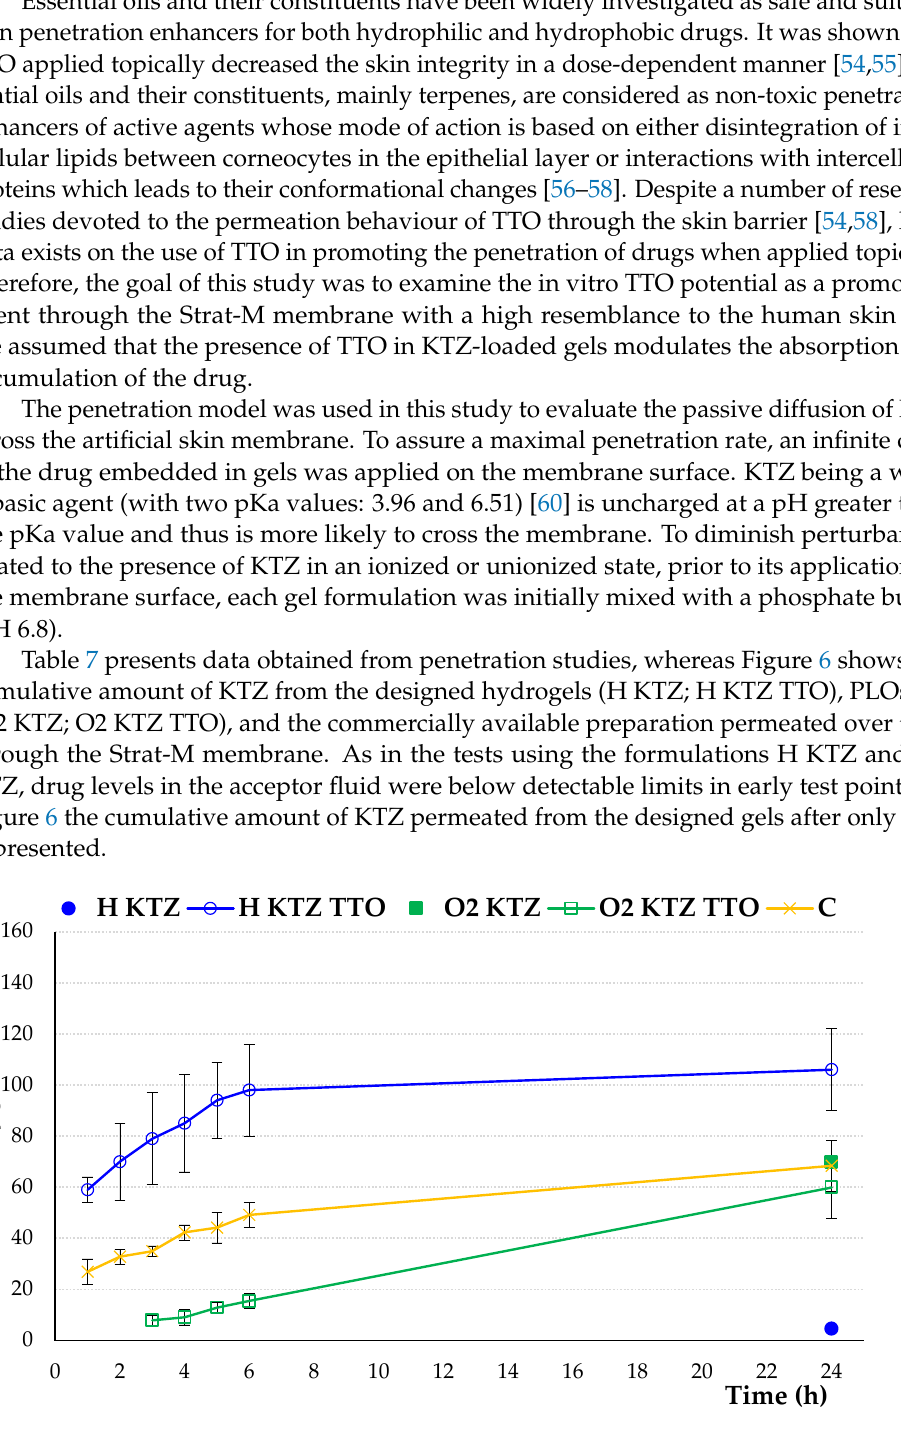
Figure 6. In vitro permeation profile (expressed as the amount of drug permeated to acceptor phase per unit membrane area) of ketoconazole (KTZ) from hydrogel (H) and organogel (O2) formulations with pure drug or combination of drug and tea tree oil (TTO) as compared to control (commercial topical preparation with KTZ (C)). Values are expressed as means ± SD of six replicates; p ˂ 0.05.